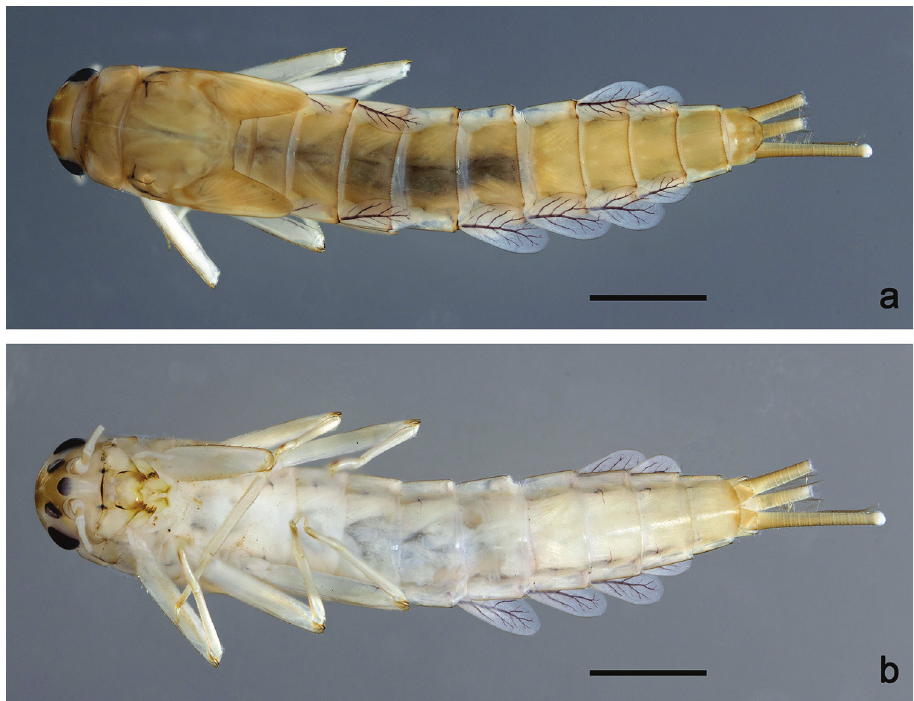
Figure 3. Labiobaetis excavatus sp. nov., habitus, nymph a dorsal view b ventral view. Scale bars: 1.0 mm. denticles and comb-shaped structure. Margin between prostheca and mola slightly convex, with minute denticles towards subtriangular process. Subtriangular process long and slender, above level of area between prostheca and mola. Denticles of mola apically constricted. Tuft of setae at apex of mola absent. Both mandibles with lateral margins almost straight. Basal half with fine, simple setae scattered over dorsal